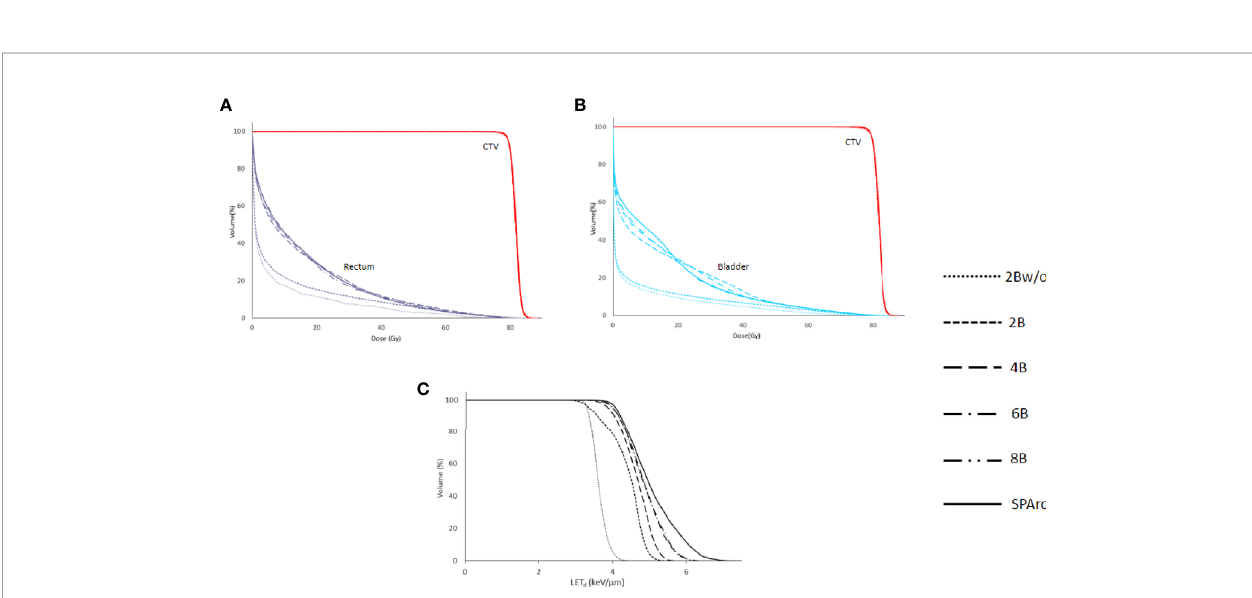
FIGURE 3 | The dose volume histograms (DVHs) (A, B) and LET d volume histograms (LVHs) (C) for 2Bw/o and for 2, 4, 6, 8 beams and SPArc with LET d based